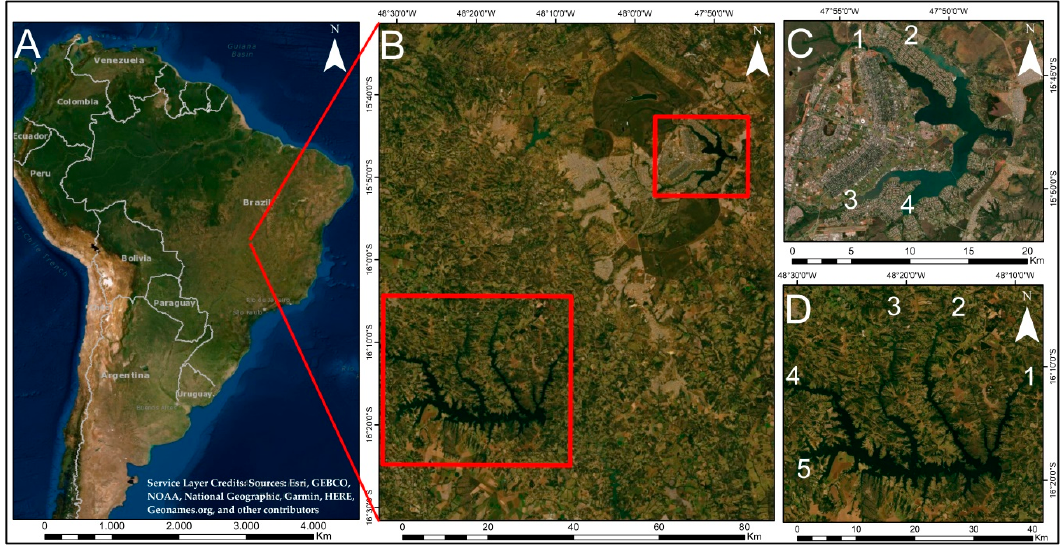
Figure 2. Location map of the urban ( Parano á - C ) and rural ( Corumb á IV - D ) reservoirs highlighting its